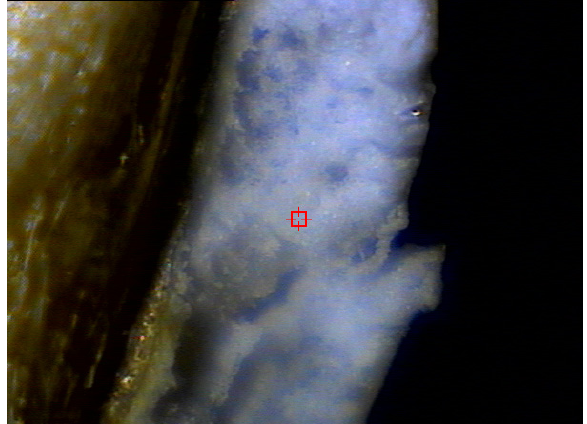
Figure 2. Camera preview with a focus point on the laser beam (red square).